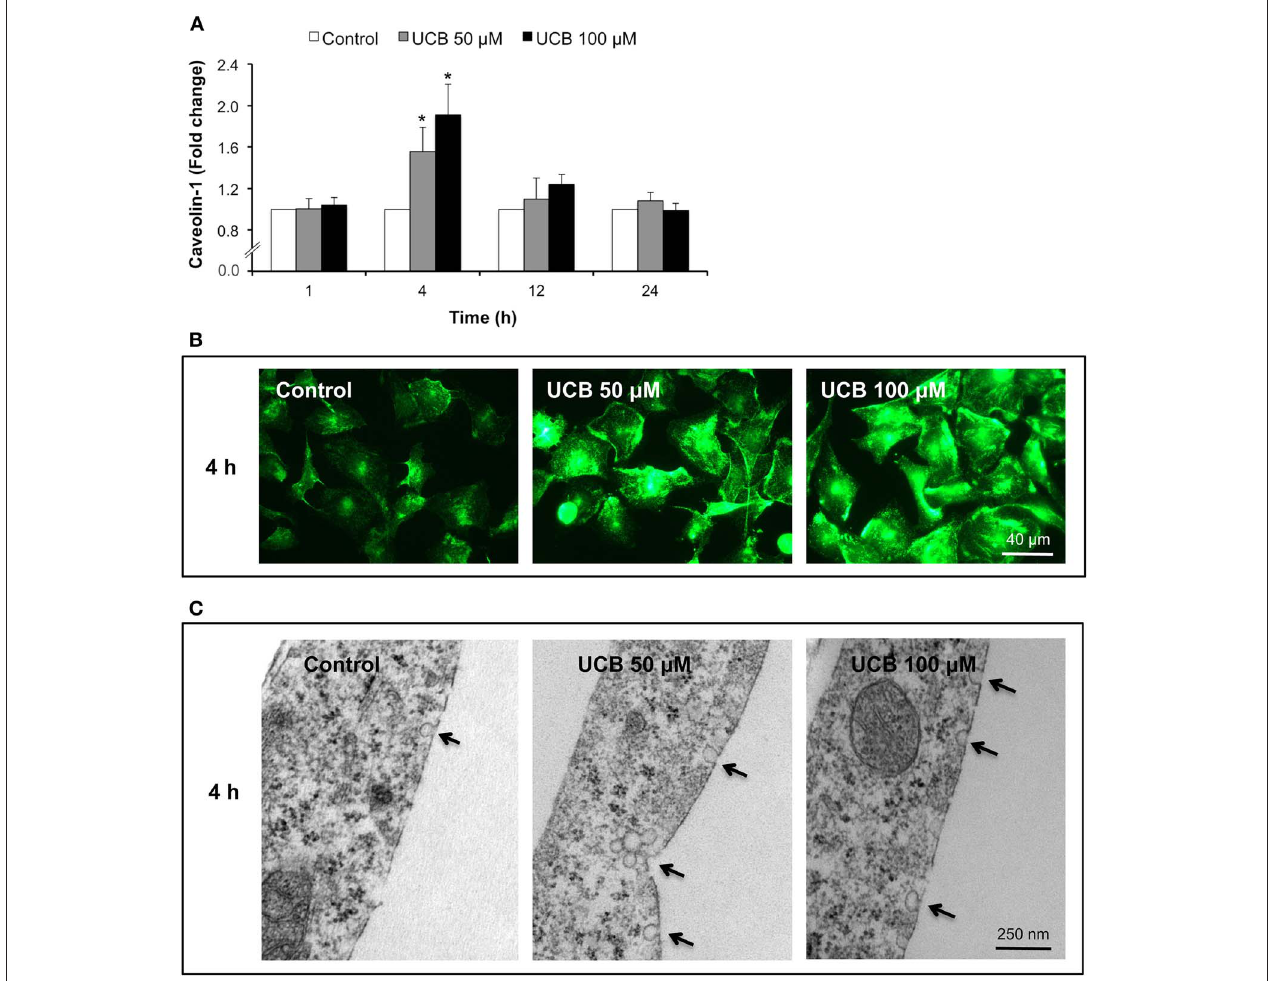
of cells. Results are shown as fold change from respective control (A) . Representative immunocytochemistry results of the 4h incubation point are shown (B) . Ultrastructural analysis by transmission electron microscopy revealed an increased number of caveolae in UCB-treated cells (arrows) (C) . Results are means ± SEM from at least three independent experiments performed in duplicate. ∗ P < 0 . 05 vs . respective